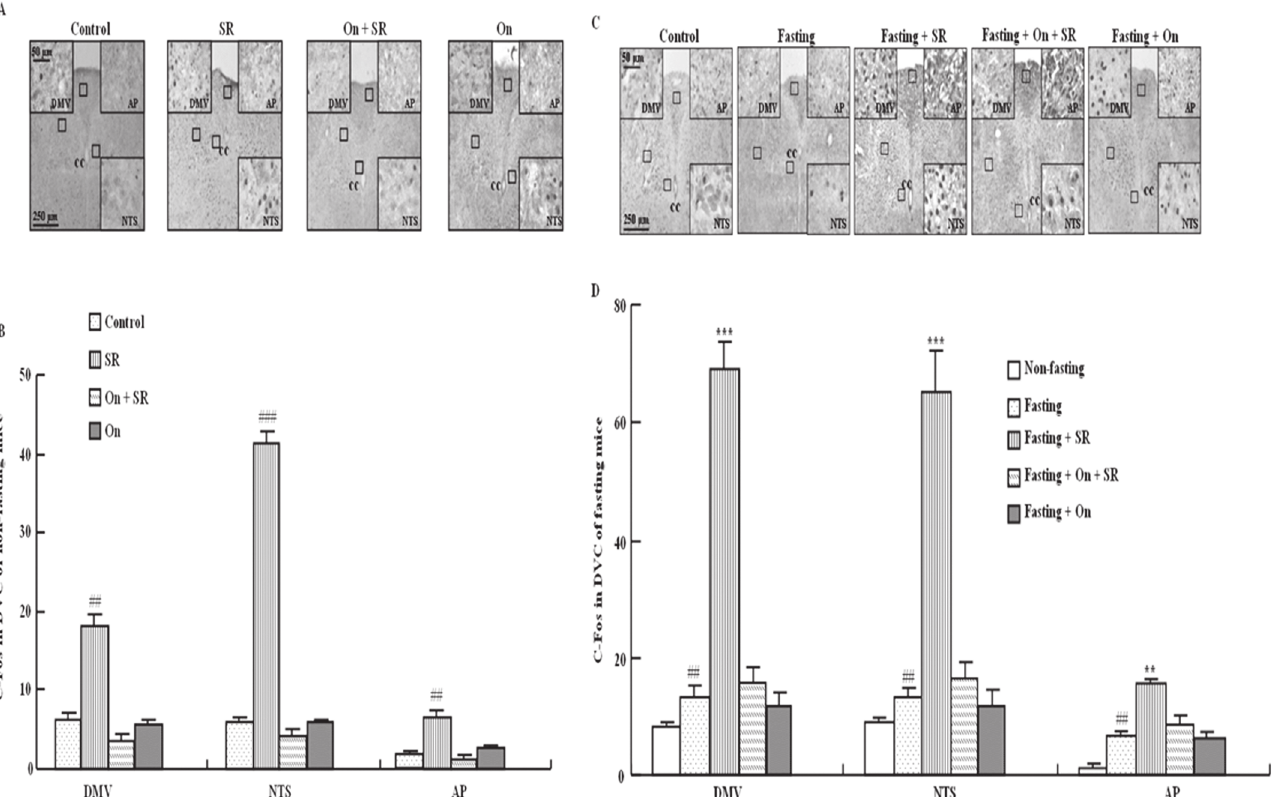
Fig 2. c-Fos expression in brain stem of fed and fasted mice. Typical photomicrographs of c-Fos expression in DVC of fed mice (A) and fasted mice (C); Mean number of c-Fos-positive cells in DVC of fed mice (B) and fasted mice (D). SR: SR 57227 (10 mg/kg, i.p.); On: ondansetron (3 mg/kg, i.p.). DVC: dorsal vagal complex; NTS: nucleus tractus solitarius; DMV: dorsal motor nucleus of the vagus; AP:area postrema; CC: central canal. Values are means ± SEM (n = 7 – 8). ##, P < 0.01; ###, P < 0.001 vs. non-fasting control group; ** , P < 0.01; *** , P < 0.001 vs. fasting control group.